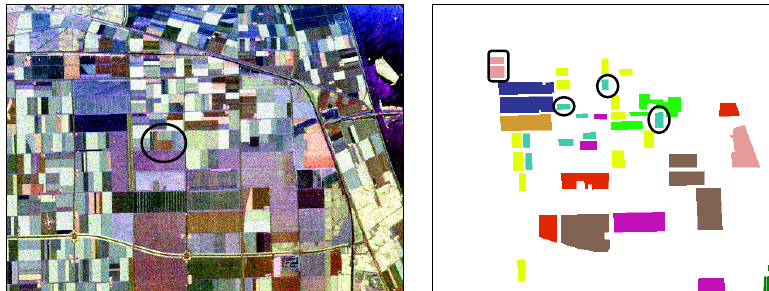
Figure 1. Pauli-RGB image of PolSAR data